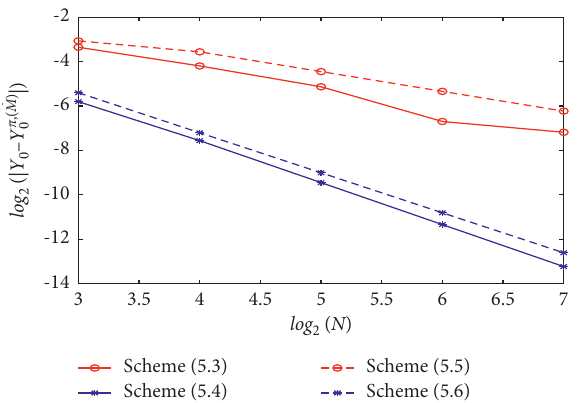
􏽥 M (| Y − Y π , |) versus log 2 0 0